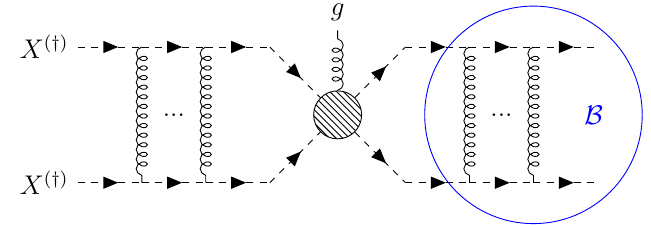
Figure 2. Feynman diagram for the radiative capture into a bound state of a scalar triplet pair (either XX † , XX , or X † X † . It consists of the (non-perturbative) initial and final state wavefunctions of the incoming particles, and the perturbative 5-point function (the grey blob) that includes the radiative vertex. The final state is then the bound state B and the radiated (on-shell) gluon g .